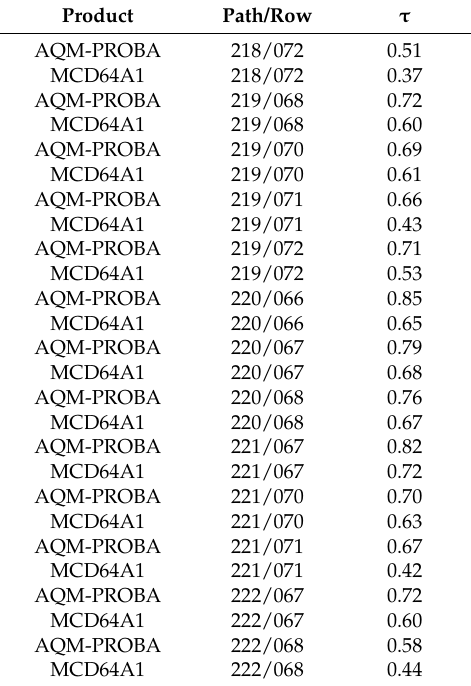
Figure 8. Scatterplots between burned area classified with the Área Queimada —Project for On-Board Autonomy-Vegetation burned area product (AQM-PROBA) and Moderate Resolution Imaging Spectroradiometer direct broadcast (DB) burned area product (MCD64A1) algorithms and the reference fire perimeters for a defined 10 × 10 km grid within each Landsat 8 scene represented by each subfigure (8a to 8l). The regression line ( blue ) and the 1:1 line ( black ) are also displayed. Table 6. Values obtained from the calculation of the Kendall correlation index ( τ ) with a confidence level of 95% for both products Área Queimada —Project for On-Board Autonomy-Vegetation burned area product (AQM-PROBA) and and Moderate Resolution Imaging Spectroradiometer direct broadcast (DB) burned area product (MCD64A1) and for each Landsat 8 scene (path/row). Product